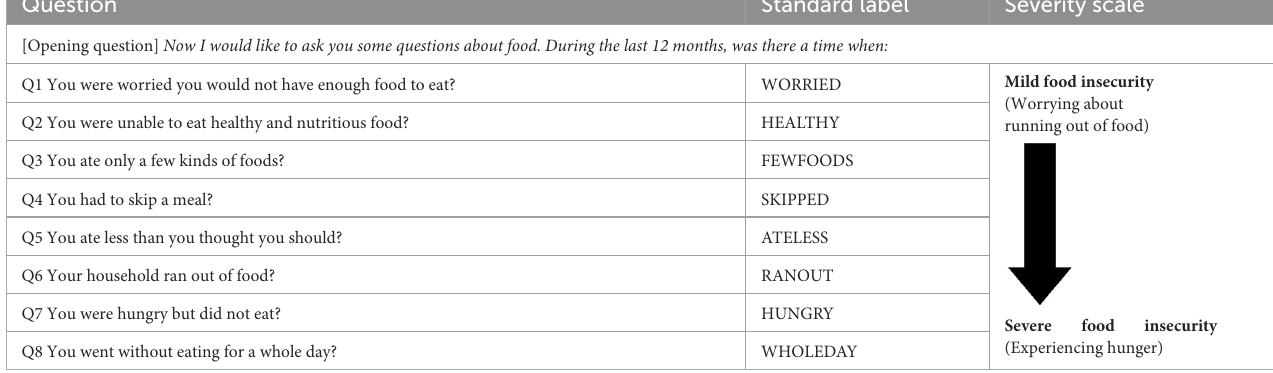
TABLE 1 FIES questions for measuring severity of food insecurity.